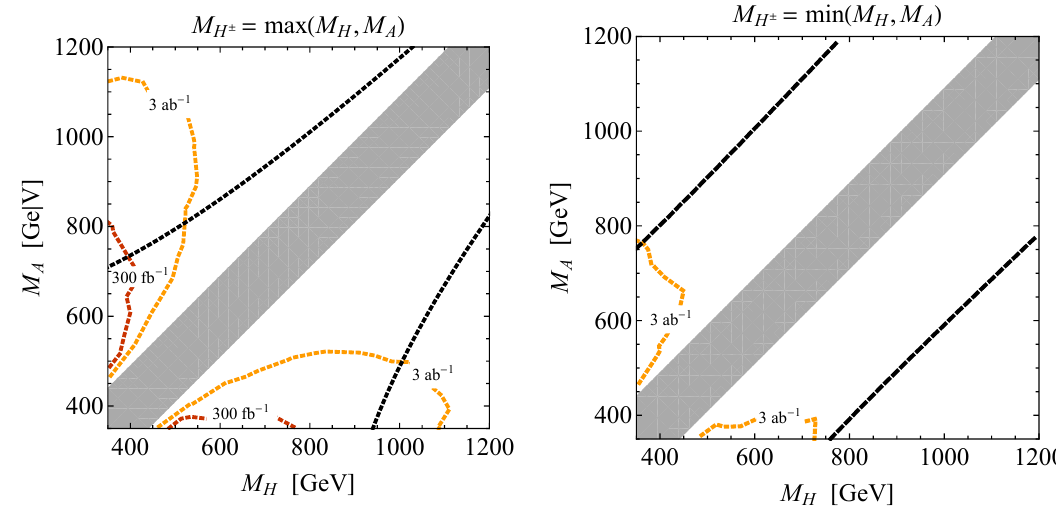
Figure 12 . Hypothetical 5 (cid:27) discovery reach in the M H { M A plane arising from a shape (cid:12)t to the (cid:1) m observable introduced in (3.4). The used input parameters and the meaning of the di(cid:11)erent elements that are shown in the two panels are identical to (cid:12)gure 9.